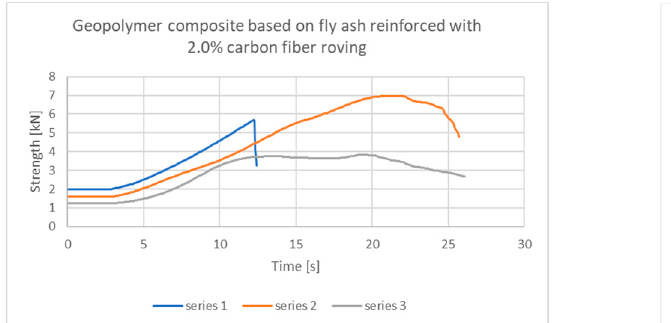
Figure 7. Strength–time composite behavior for a geopolymer matrix based on: ( a ) fly ash with 2.0% carbon fiber roving; ( b ) metakaolin with 2.0% carbon fiber roving.